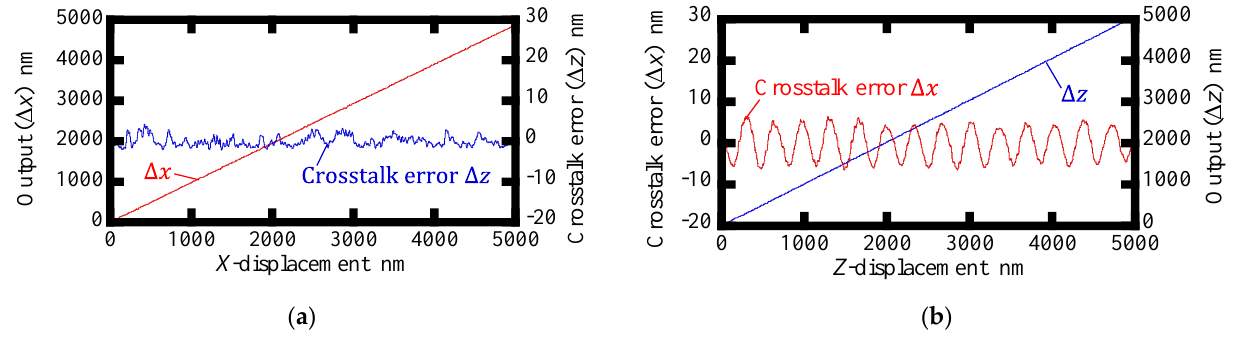
ment between the sensor head and the axes of the scale grating are removed in Figures 8 and 9. A more careful alignment of the setup is expected to reduce the linear components.